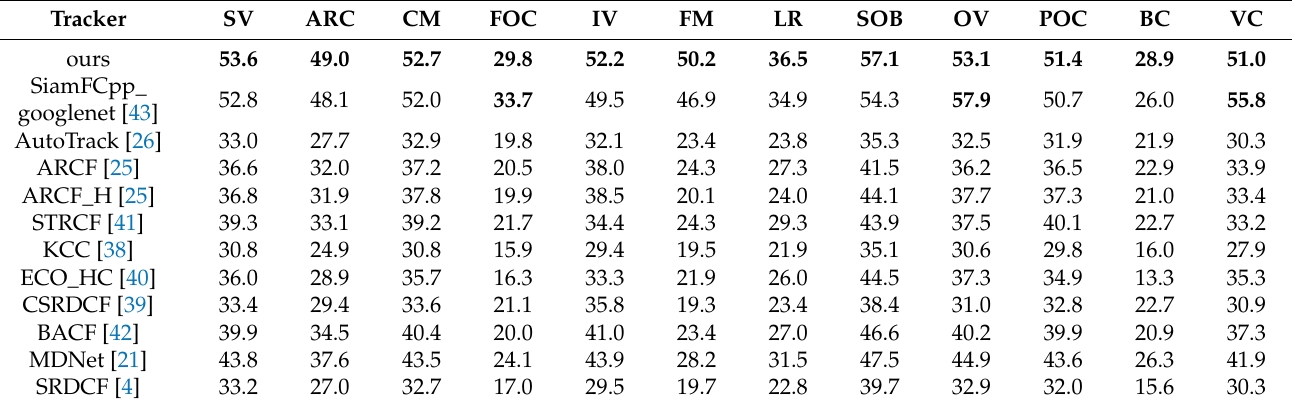
Table 5. AUC comparison results of the state-of-the-art trackers on the UAV20L dataset.